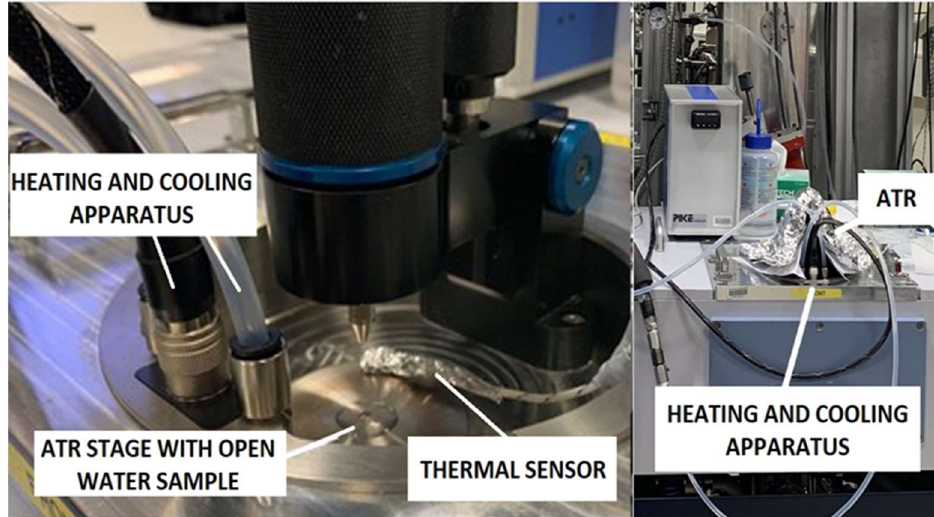
Figure 2. Experimental layout. The foil cover shown in the illustration on the right was used to aid in the initial cooling of the apparatus to 14 °C and to aid sample temperature uniformity during the heating